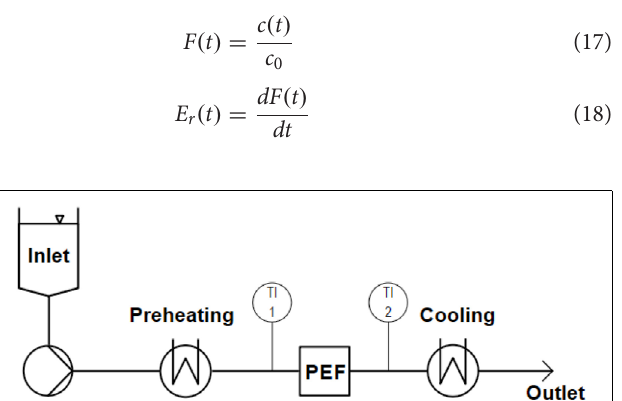
FIGURE 3 | Scheme of the used continuous PEF equipment, including an inlet tank, a screw pump, heat exchangers for preheating and cooling, inlet (TI 1) and outlet (TI 2) temperature sensors, and the PEF treatment chamber (co-linear or vortex configuration).